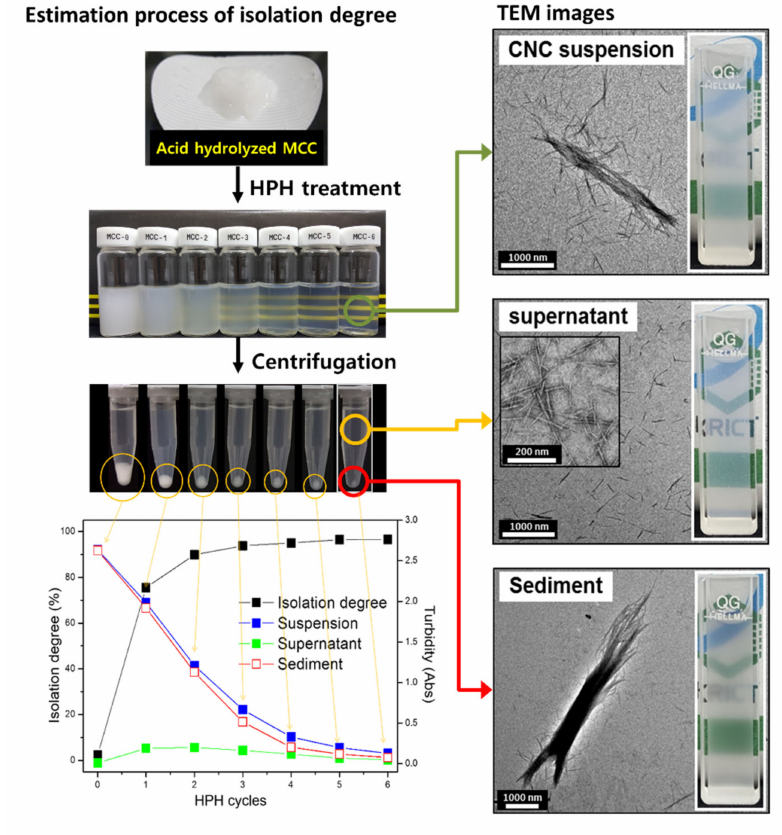
Scheme 1. Schematic diagram for estimation of isolation degree of CNCs suspensions from MCC according to high-pressure homogenizer (HPH) treatment with turbidimetry.